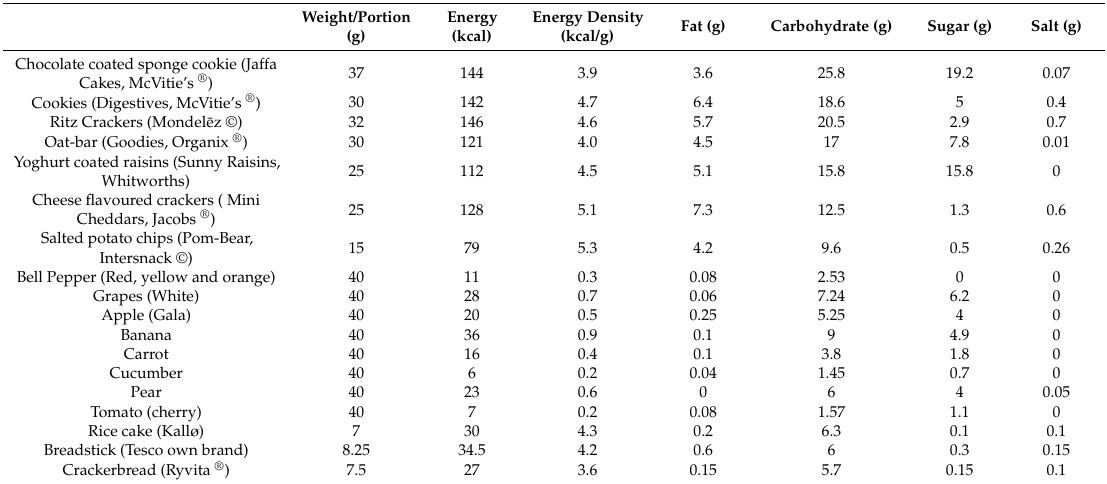
Table 1. Nutritional composition of snacks included in week 2 and 3 snacking schedules (per portion).